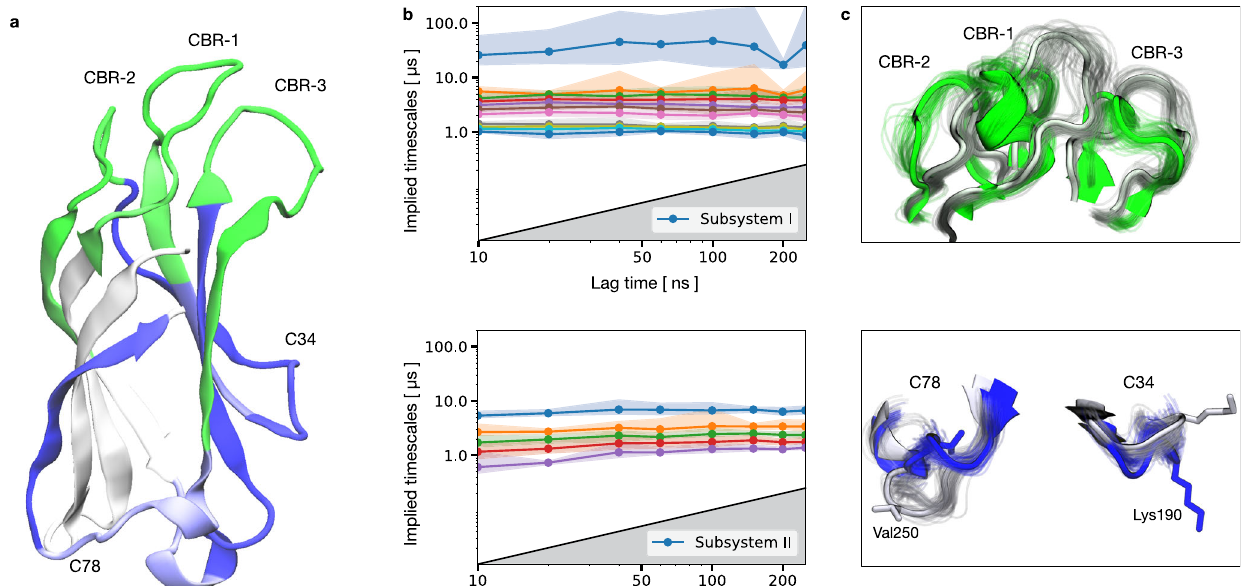
Fig. 5 | iVAMPnet of synaptotagmin-C2A with two subsystems and twelve and six states, respectively. a Importance values of the trainable mask depicted as color-coded protein secondary structure, indicating assignment to subsystem I (II) in green (blue). b Implied timescales of the two subsystems with a 90% percentile over 20 runs (dot markers denote means), color-coded by index. c Superposed representativestructuresofbothextremaoftheslowestresolvedeigenfunctionsof